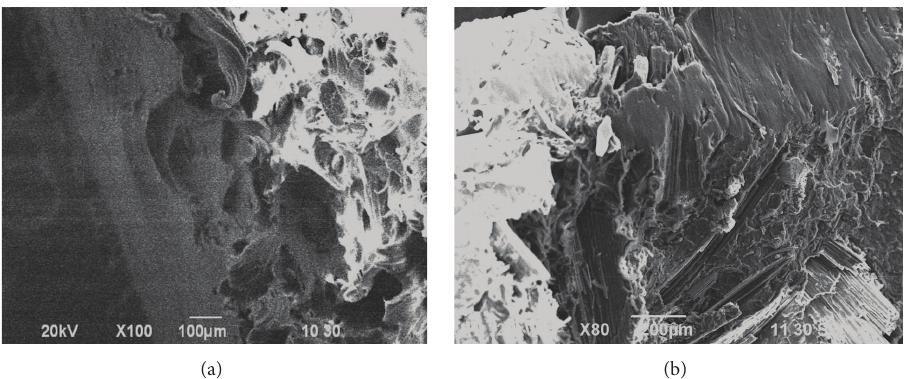
Figure 8: SEM images of tensile fractured surfaces of (a) NaOH treated composites and (b) untreated